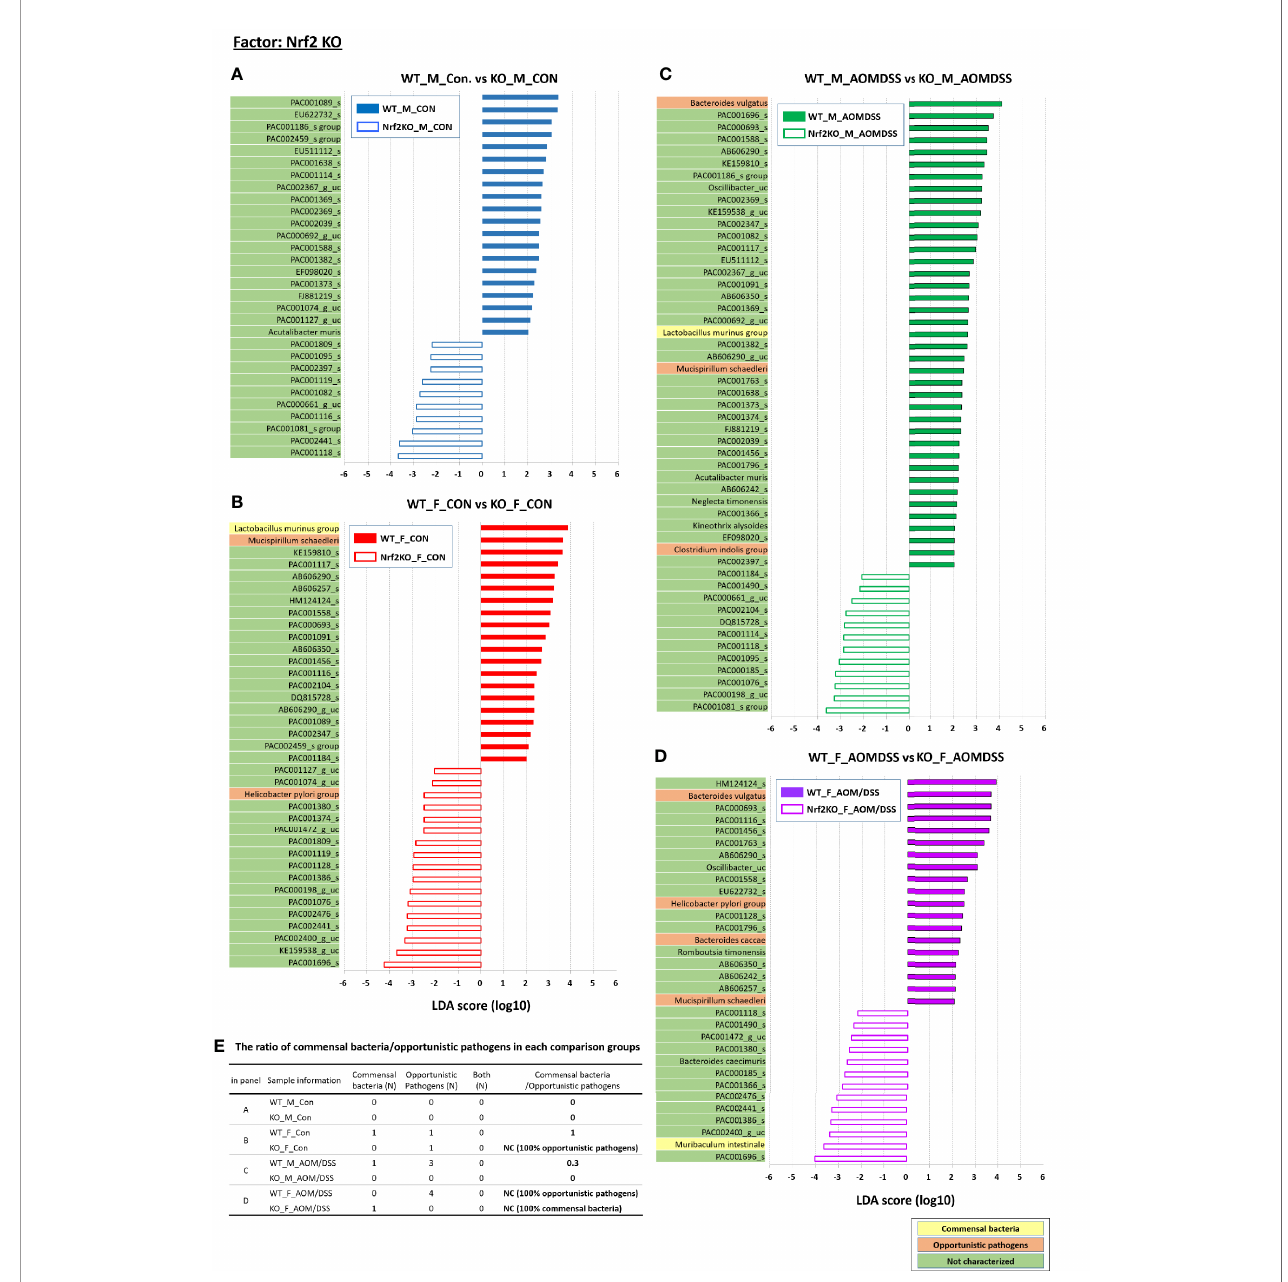
FIGURE 7 | Nrf2 KO-speci fi c alterations in the abundance of gut microbiota examined using LEfSe. Bar plots of the LEfSe results, which were generated based on the criteria mentioned in the legend of Figure 5 . Bar plots at the species level with signi fi cant differences in abundance based on the LEfSe results. The color bars and lines show the LDA scores of species that are enriched in the indicated condition; (A) blue bar (WT male controls), (A) blue line (Nrf2 KO male controls), (B) red bar (WT female controls), (B) red line (Nrf2 KO female controls), (C) green bar (WT male AOM/DSS-induced CRC), (C) green line (Nrf2 KO male AOM/DSS-induced CRC), (D) purple bar (WT female AOM/DSS-induced CRC), and (D) purple line (Nrf2 KO female AOM/DSS-induced CRC). Each color on the species name indicates the characteristics of each genus: yellow for commensal bacteria, orange for opportunistic pathogens, and green for not characterized bacteria. The p -values were determined using the non-parametric factorial Kruskal – Wallis sum-rank test. (E) The ratio of commensal bacteria to opportunistic pathogens based on the LEfSe results in each comparison group. CRC, colorectal cancer; LDA, linear discriminant analysis; LEfSe, LDA effect size; WT, wild-type; KO, Nrf2 knockout; Con, control; AOM, azoxymethane; DSS, dextran sodium sulfate; M, male; F, female; N, number; NC, not